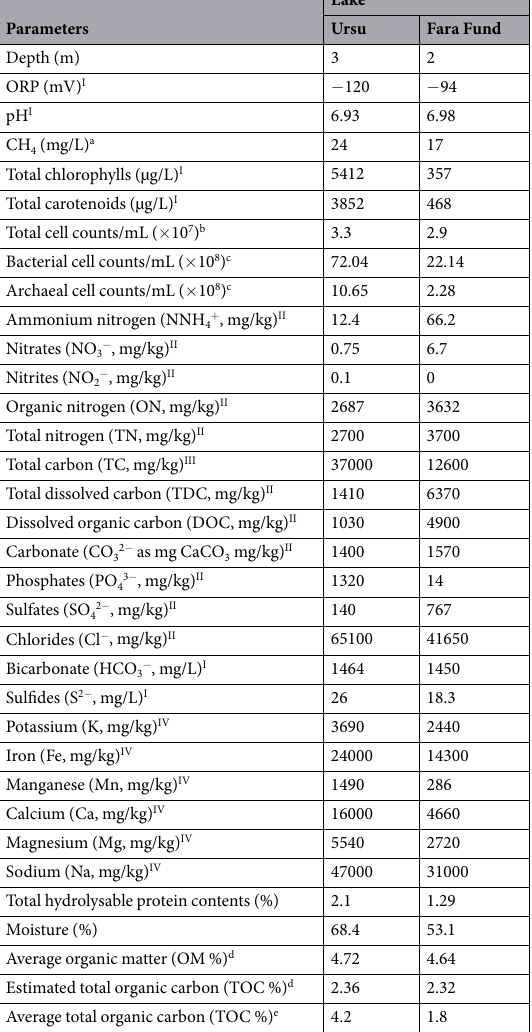
Table 1. Physicochemical and biological characteristics of the sapropels collected from Ursu and Fara Fund lakes (Transylvanian Basin, Central Romania) during October 2013. I Measured from pore water. II Measured as water-extractable compounds from dried sediments. III Measured directly in the dried sediments. IV Measured in dried sediments digested with aqua regia (HCl:NHO 3 = 3:1). a Measured at sediment-water interface. b DAPI (4 ′ ,6-diamidino-2-phenylindole, dihydrochloride) cell counts. c RT-qPCR (real-time quantitative PCR) cell counts. d Estimation based on loss-on-ignition method. e Estimation based on wet oxidation